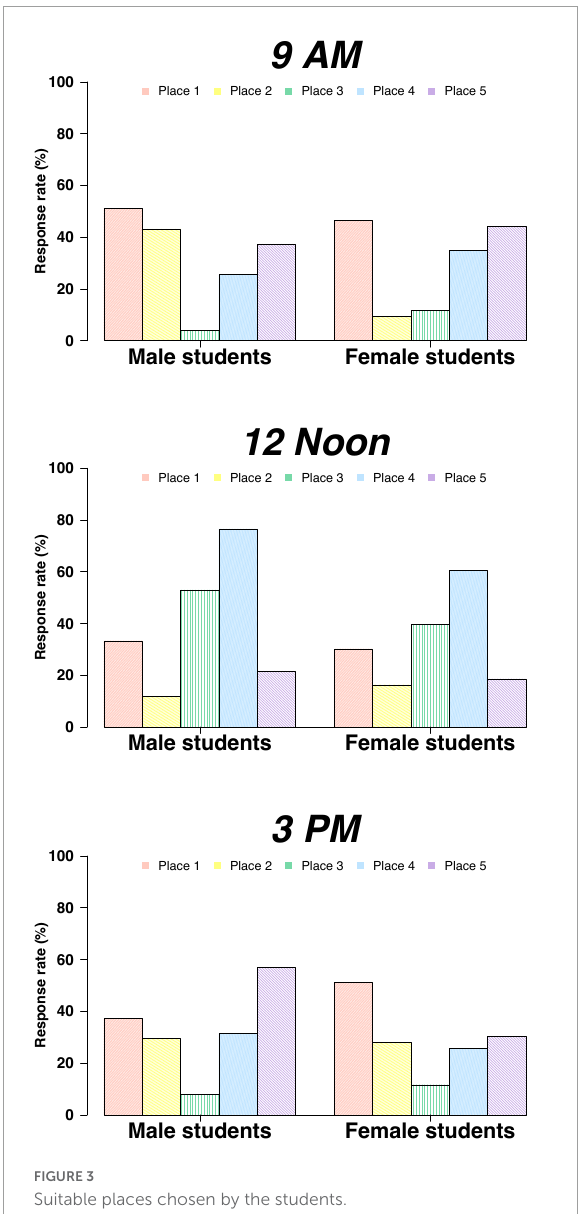
FIGURE3 Suitable places chosen by the